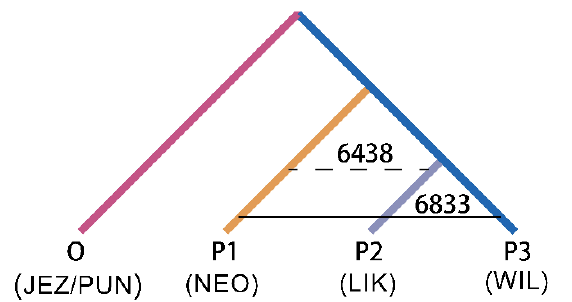
Figure 4. ABBA-BABA test tree model of five spruce species. NEO, P. neoveitchii from Gansu and Shaanxi; WIL1, P. wilsonii from Shanxi and Hubei; others are the same as in Figure 1. Table 1. ABBA-BABA test of five spruce species.